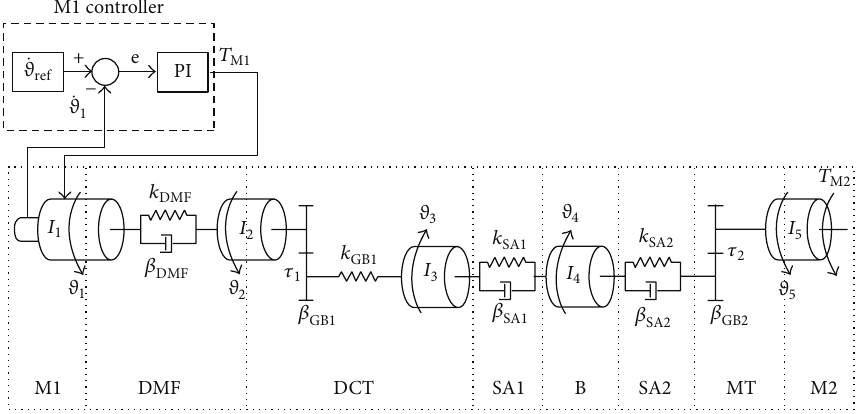
Figure 3: Torsional model of the test bench.